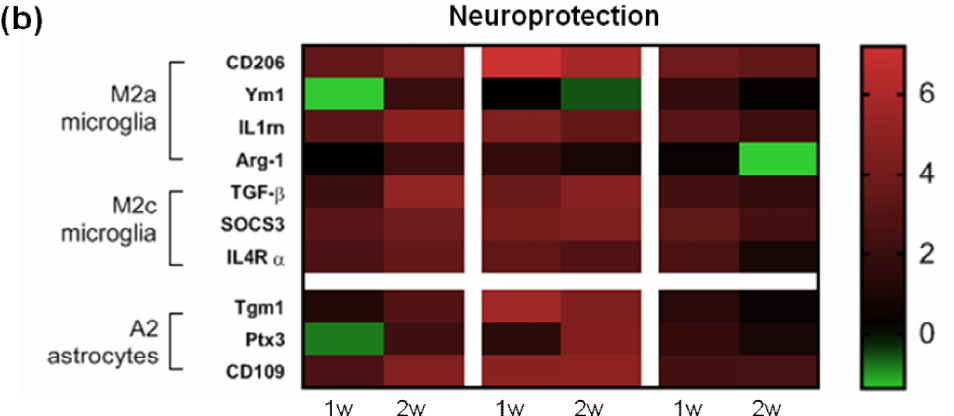
Figure 6. Heat map of genes belonging to the neuroinflammatory ( a ) and neuroprotective ( b ) mi- croglia/macrophages and astrocytes. The horizontal axis represents time following Th9 compression at the lesion site, then cranially and caudally and the vertical axis represents specific genes. Black indicates no change in relative ∆∆ C t values relative to controls, whereas shades of green or red represent a decrease or increase of marker values. Imaging software: GraphPad Prism (version 8; GraphPad Software Inc., San Diego, CA,